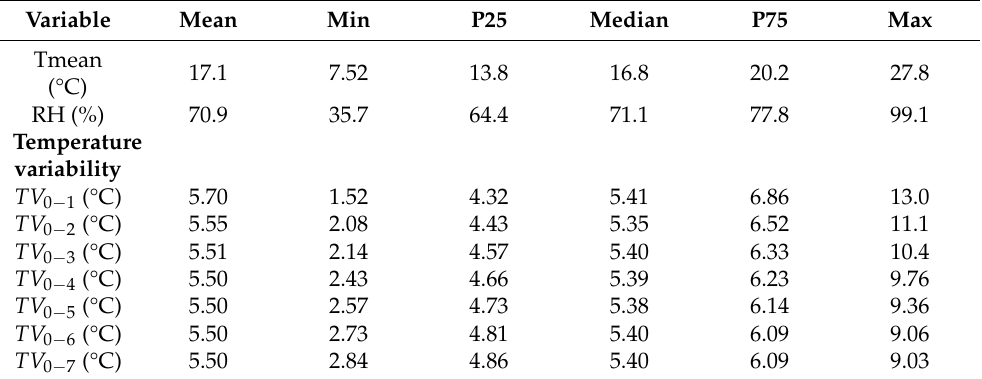
Table 2. Distribution of weather conditions and temperature variability at different exposure days in the City of Cape Town, 1 January 2011–31 October 2016.